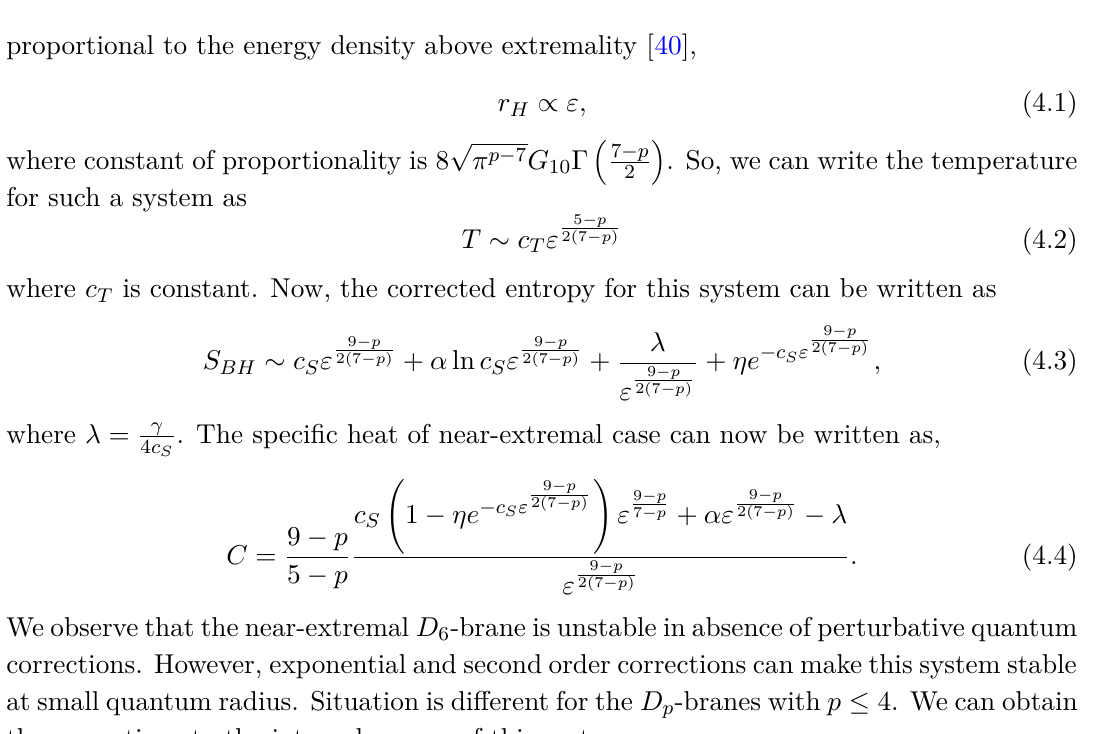
Figure 3 . Helmholtz free energy in terms of horizon radius for β = 1